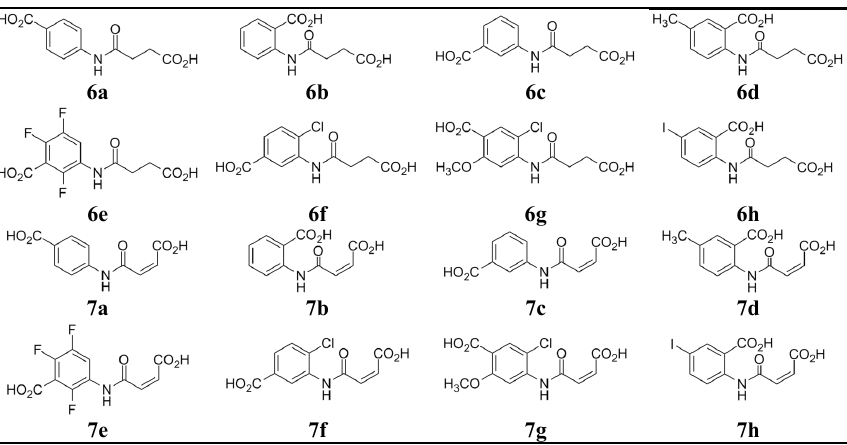
Figure 2. Structures of the tested compounds.